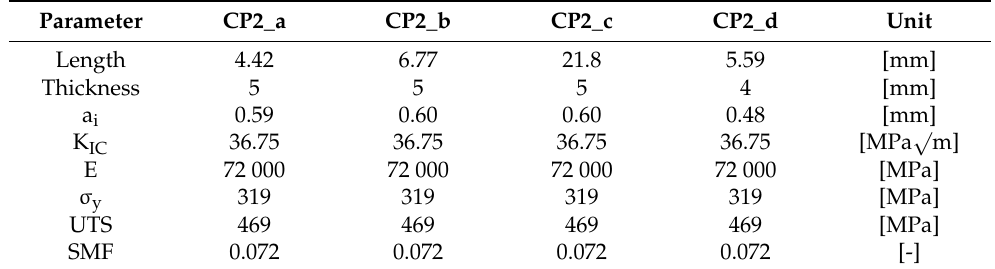
Table 2. Cracks initial parameters and material properties of the considered 2024-T4 aluminium alloy.